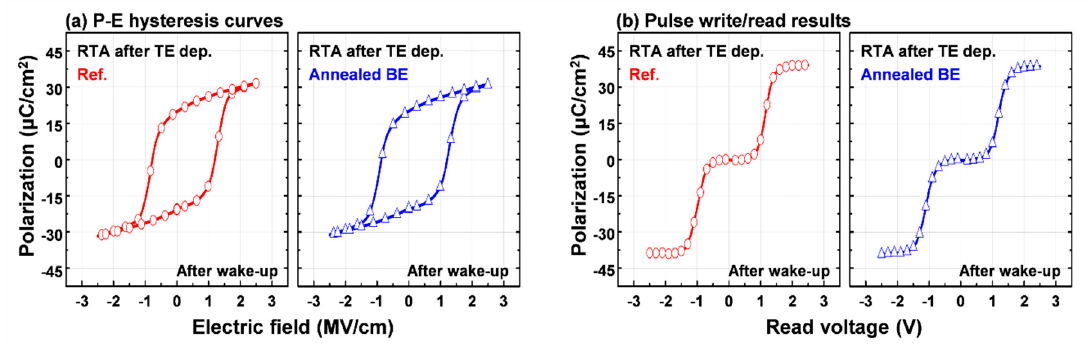
Figure 3. ( a ) The polarization-electric field hysteresis curves and ( b ) pulse write/read results of the 10-nm-thick HZO-based MIM capacitors annealed at 400 °C.